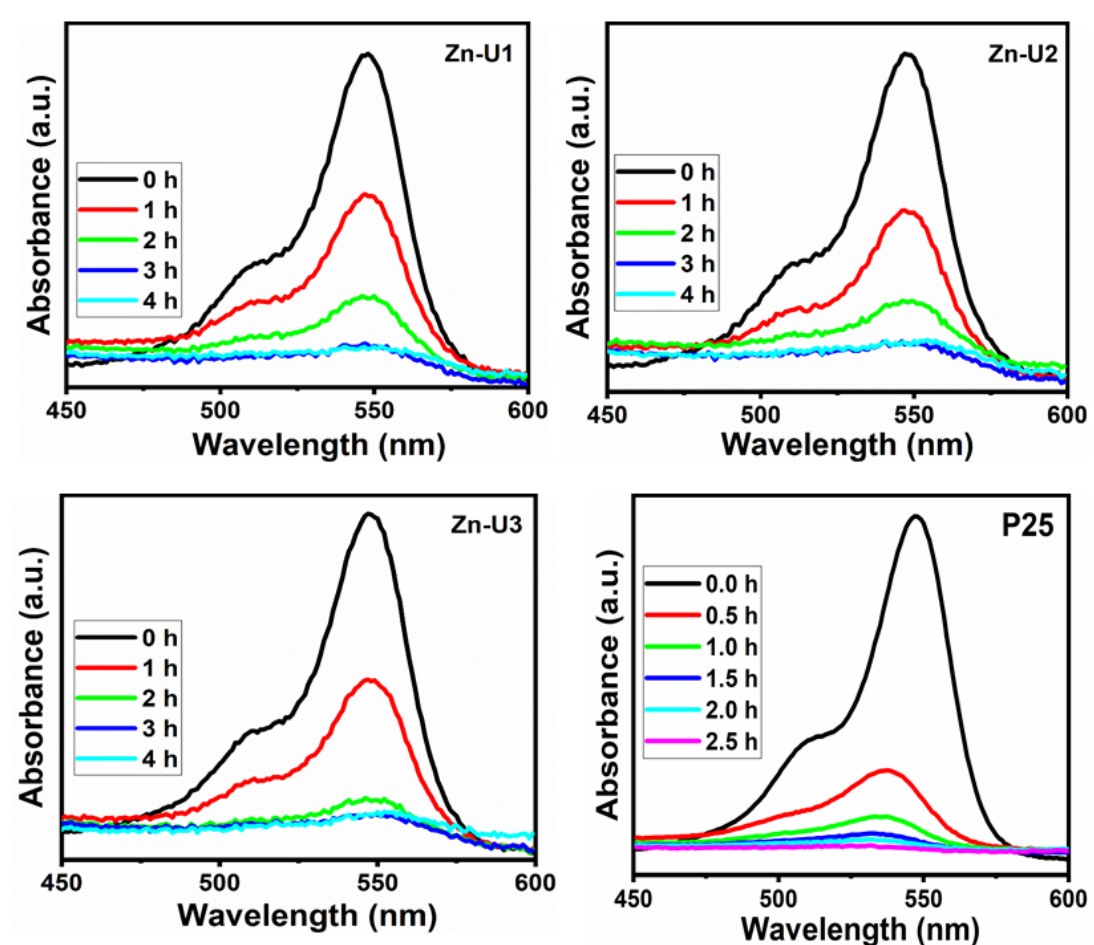
Figure 8. Time dependent spectral change of Rose Bengal (RB) solution catalyzed by Zn-U1, Zn-U2, Zn-U3, and P25 photocatalysts under UV-light irradiation.